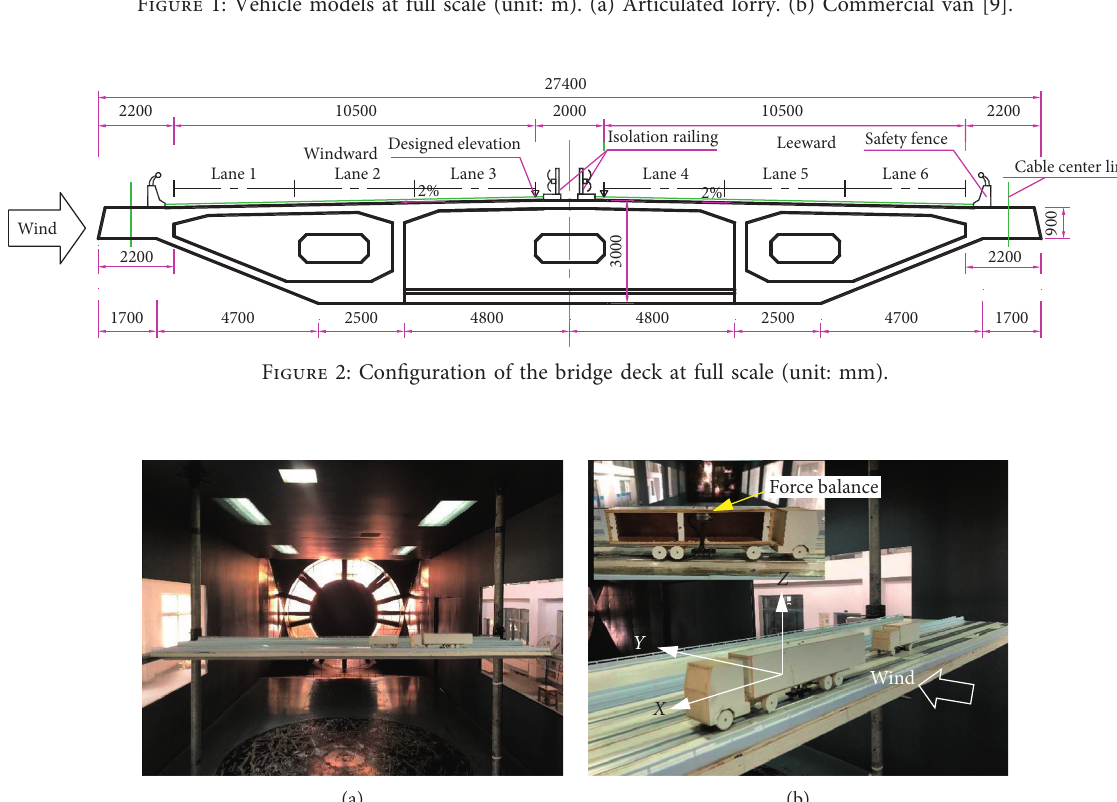
Figure 1: Vehicle models at full scale (unit: m). (a) Articulated lorry. (b) Commercial van [9].